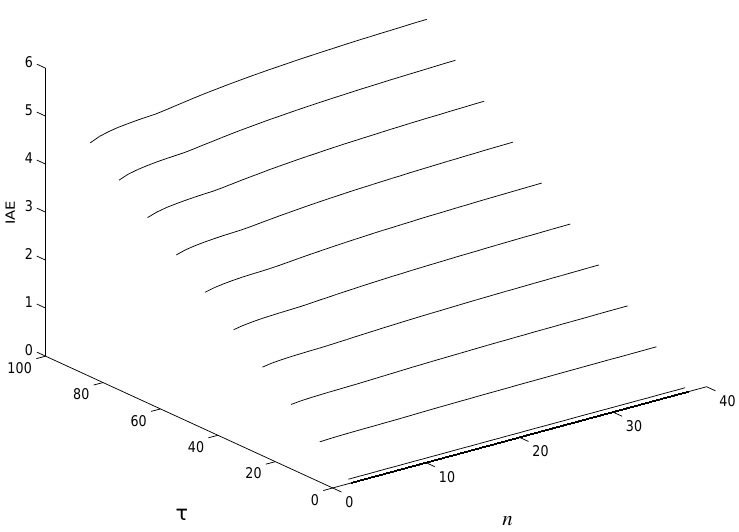
Figure 9. Values of the integrated absolute error ( IAE ) for different values of τ and n (process order) with a PI controller tuned according to the benchmark tuning